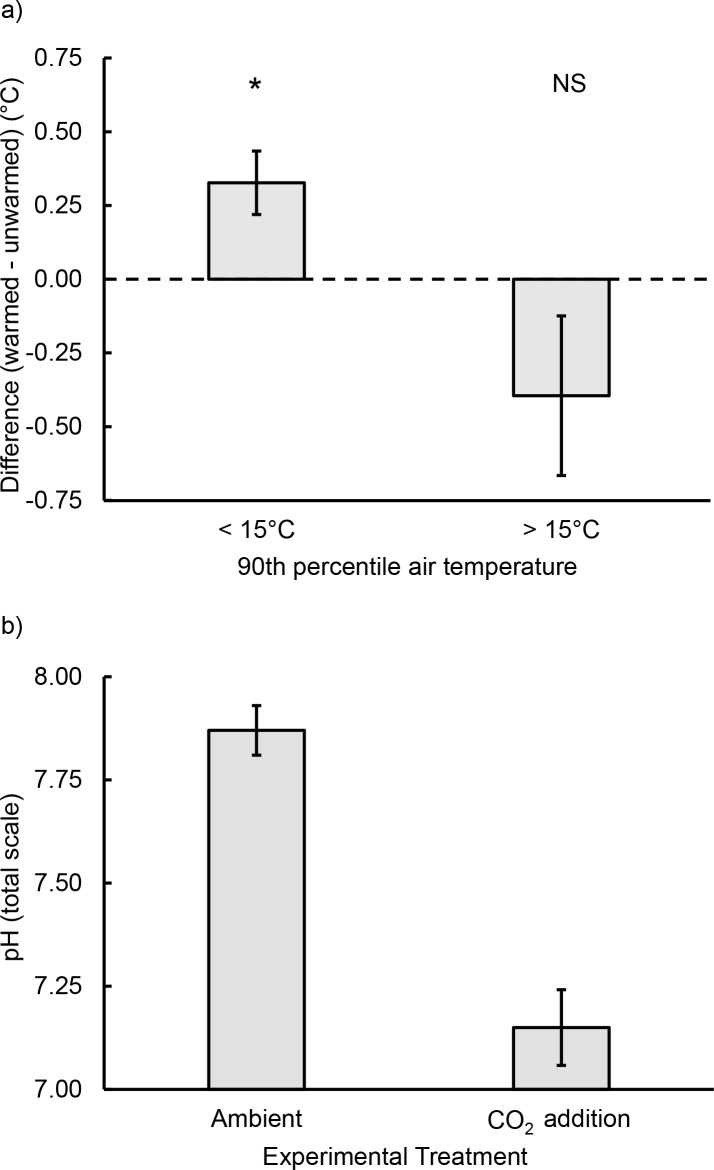
Effects of experimental warming and CO2 addition on tide pools.(a) Effects of warming on tide pool temperatures depended on air temperature. Experimental warming increased pool temperatures on cooler days (≤ 15°C) but not when air temperatures were ≥ 15°C. Values are the 90th percentiles of air temperatures (x-axis) and difference between 90th percentile temperatures in warmed vs. ambient pools (y-axis) on each day. Statistical significance is indicated: p < 0.05 (*), p > 0.05 (NS). (b) Compared to pools at ambient CO2 levels, experimental manipulations led to decreases in average pH (total hydrogen ion scale). Values are means ± SE.